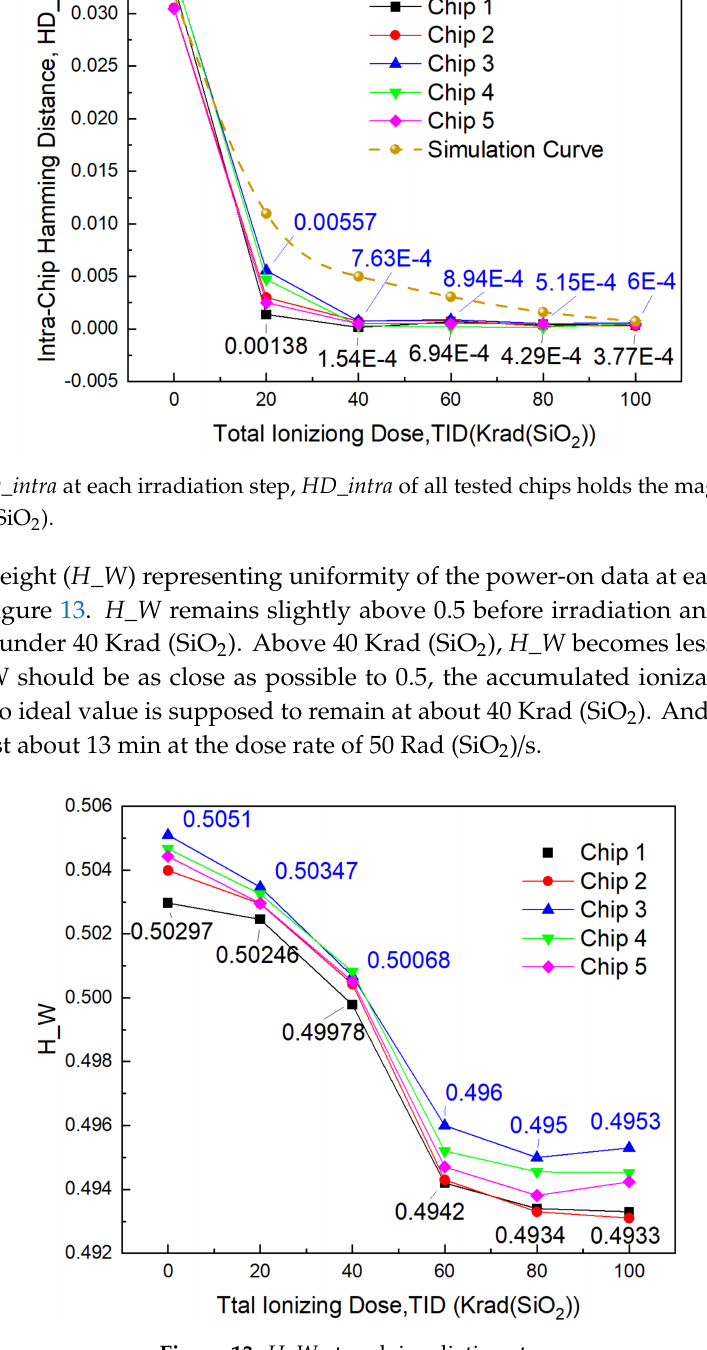
Figure 13. H _ W at each irradiation